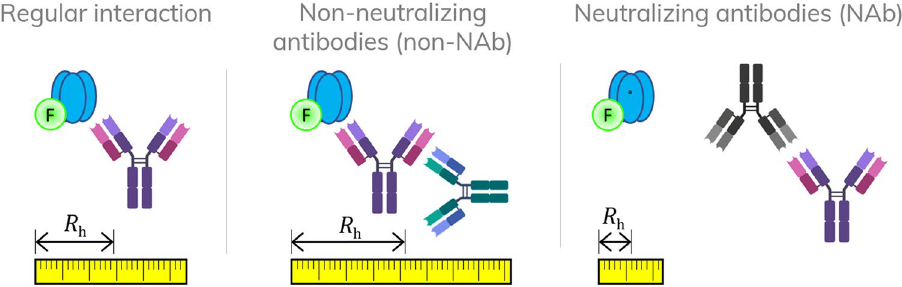
Figure 1. Schematics showing ADA classification as function of apparent hydrodynamic radius ( R h ) of TNF- α-AF488 (indicator) and adalimumab (analyte). TNF-α-AF488 is illustrated as a soluble homotrimer (blue) conjugated to a fluorophore (green) which enables selective R h measurements via fluorescence detection. Adalimumab is exemplified as an antibody (bordeaux) targeted by non-neutralizing antibodies (orange) and neutralizing antibodies (black). The yellow ruler illustrates the link between R h , normal drug activity (left), and presence of ADAs (middle and right). Created by author Morten E. Pedersen using